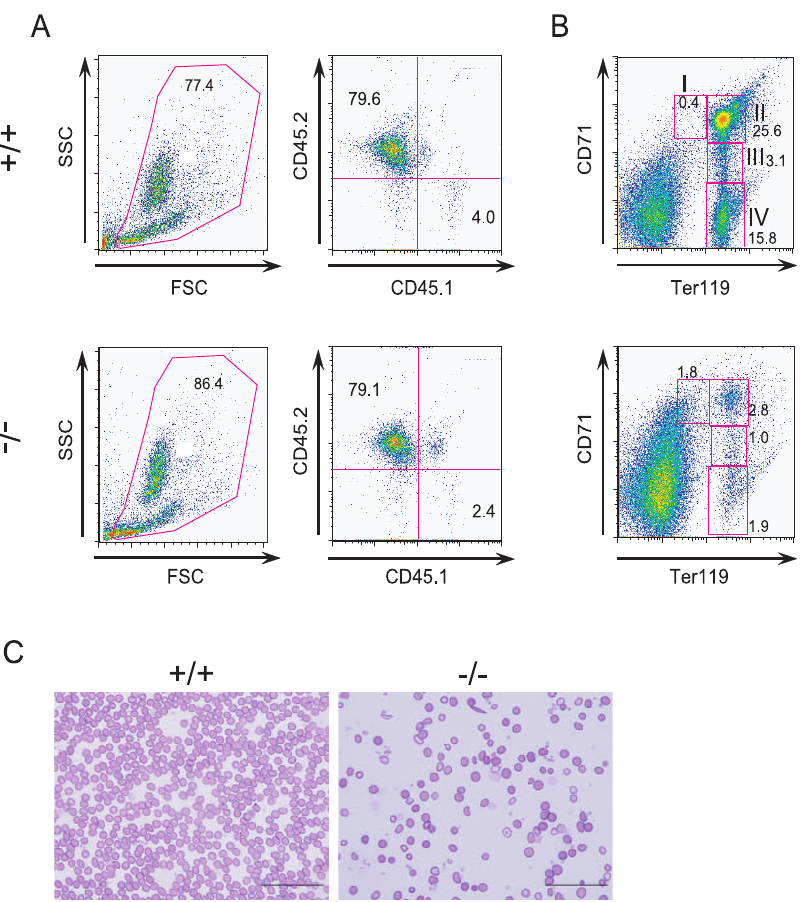
Figure 4. CALM is required for normal erythropoiesis. (A) CD45 profile of peripheral blood cells from transplanted mice 9 weeks after transplantation. (B) FACS analyses of erythroblasts at different maturation stages from transplanted mice using anti-TER119 and anti-CD71 Abs. (C) Peripheral blood smears from mice transplanted with fetal liver cells from either wild-type littermates or CALM -deficient embryos. Scale bar, 50 m m. In A, B, and C, ( + / + ) and ( 2 / 2 ) represent host mice transplanted with cells from wild-type and CALM -deficient mice, respectively.